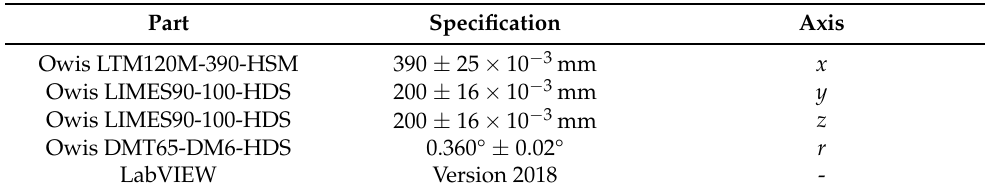
Table 1. Test bench parts, part specification and axis